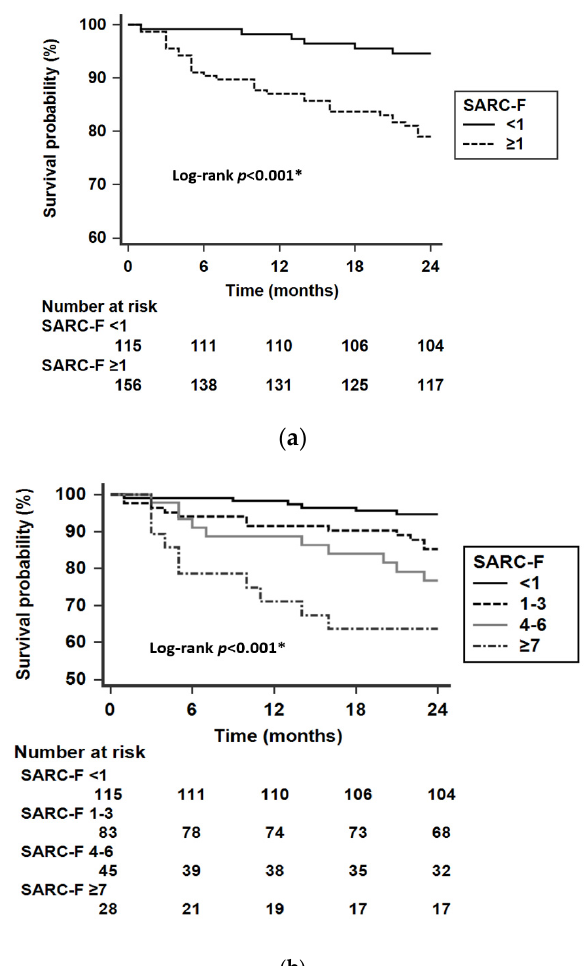
The best cut-off of SARC-F score to predict mortality was ≥ 1, which provided 85.0% sensitivity